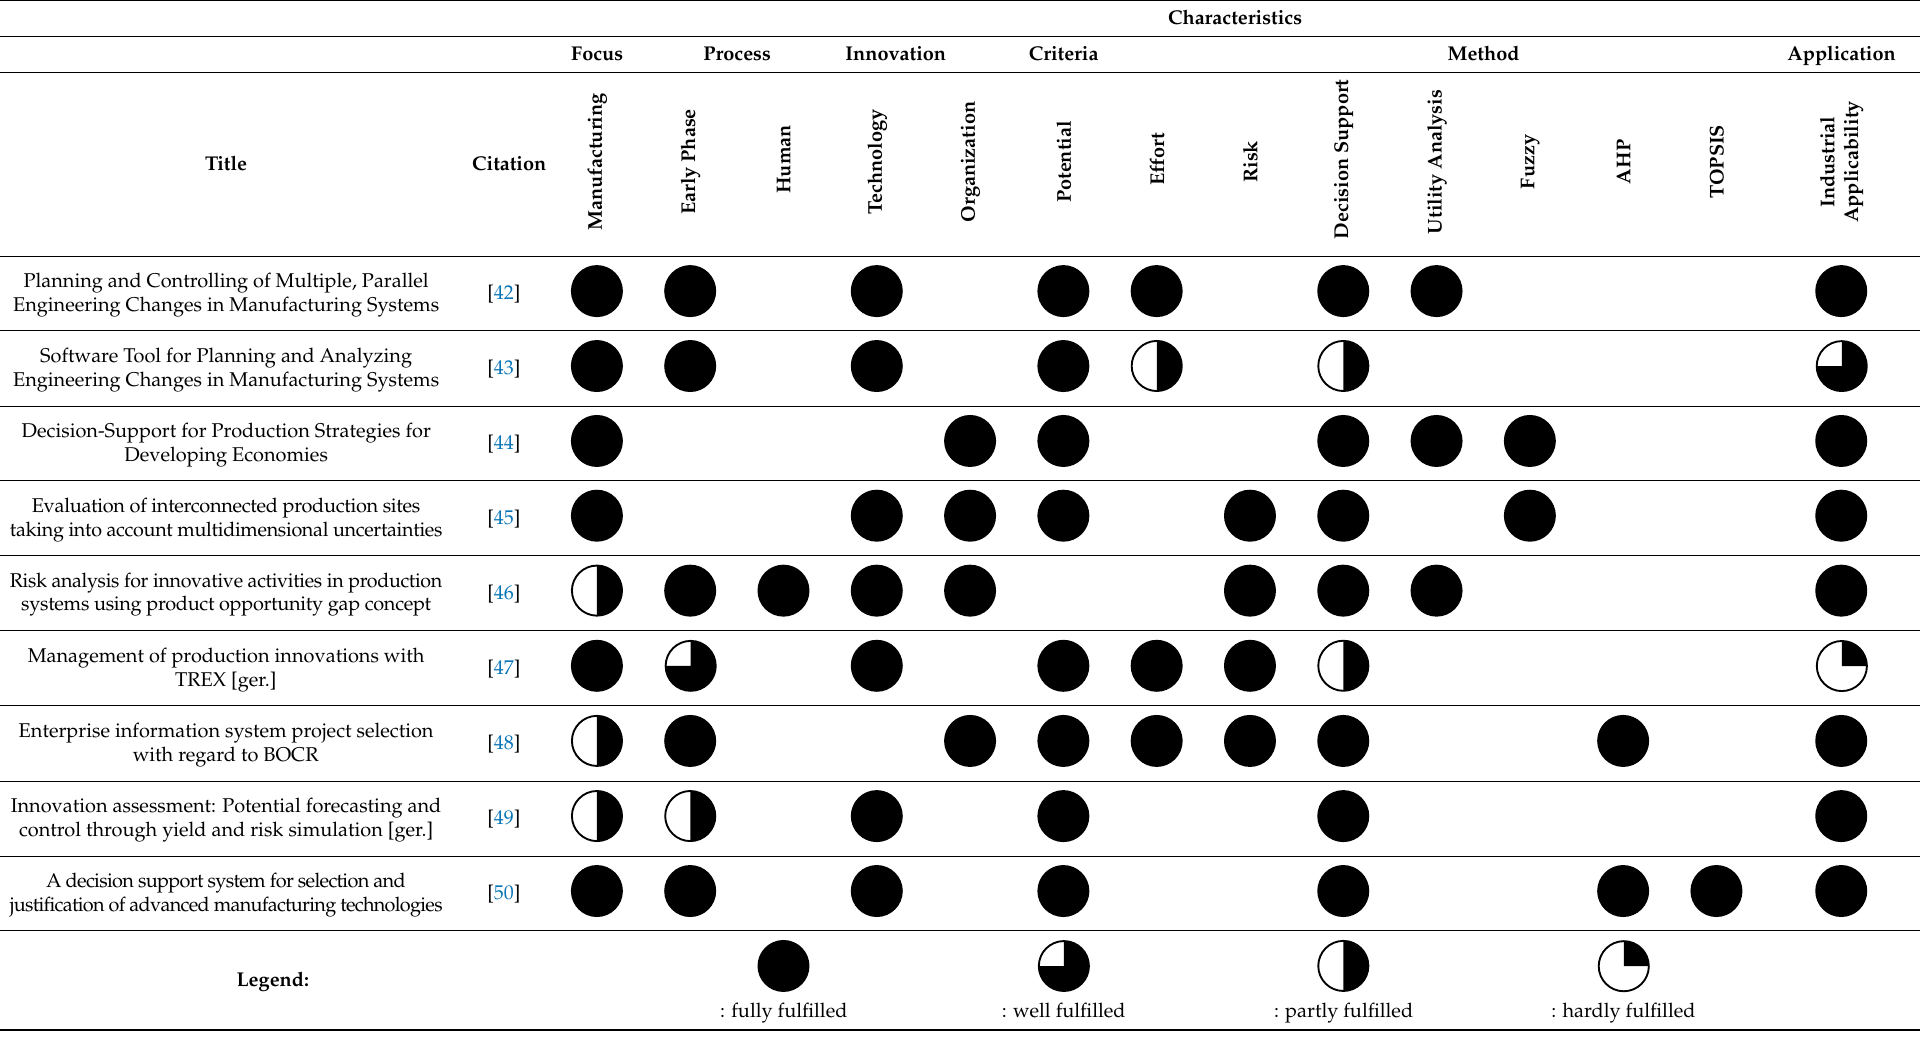
Table 2. Result analysis for the investigated methodical approaches.